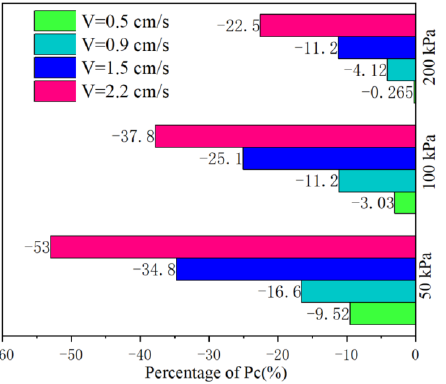
Figure 5. Change of coordination number characterizing the softening process of the slip zone soil: ( a ) 50 kPa; ( b ) 100 kPa; ( c ) 200 kPa.